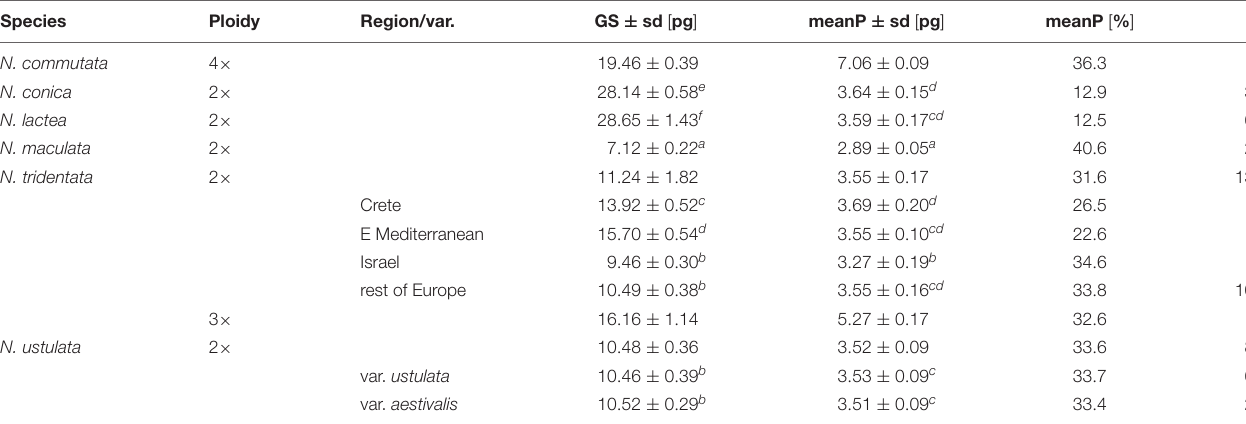
TABLE 1 | Variation in genome size (2 C -value) and the size of the endoreplicated part of the genome (size corresponding to the 2 C -value and percentage) within recognized taxa and their variants or regional evolutionary lineages revealed by phylogenetic analyses based on RADseq data ( Figure 6 ). Species Ploidy